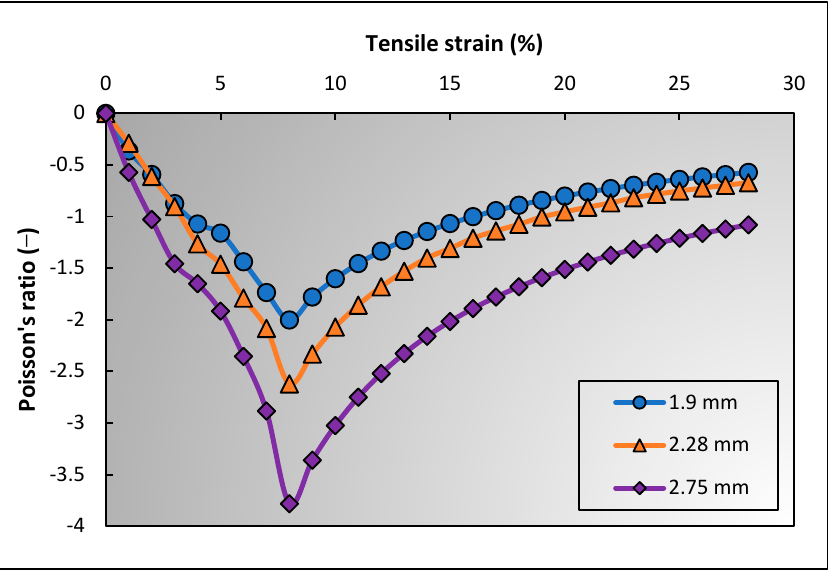
Figure 13. Effect of binding yarn diameter on auxetic behavior of 3D woven structure.